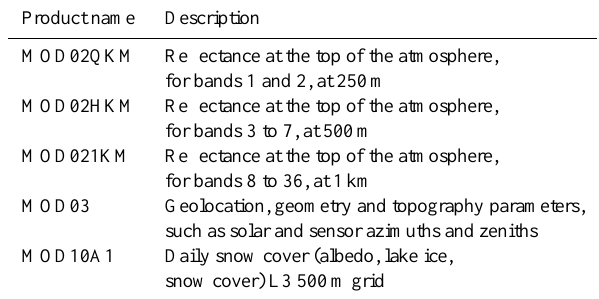
Table 1. Description of the MODIS products used in this study. Product name